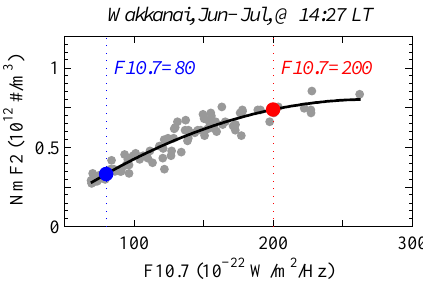
Figure 1. Scatter plots of Wakkanai monthly median Nm F2 vs. F 10 . 7 in June–July. The solid line is the quadratic regression fitting of the data, and the blue and red dots show the fitted Nm F2 for the two solar activity levels of F 10 . 7 equals 80 and 200, respectively.